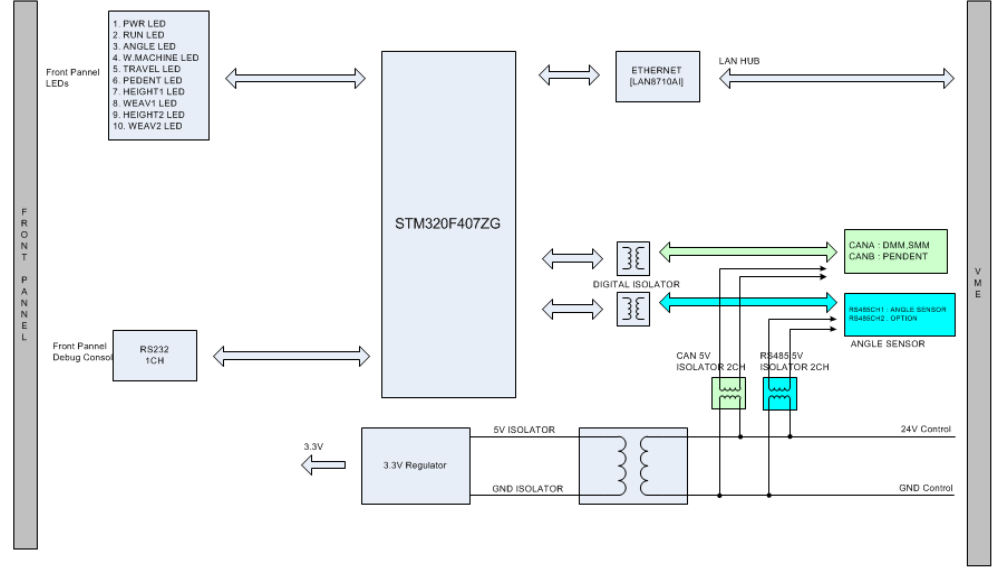
Figure 9. Welding control module (WCM) board block diagram.